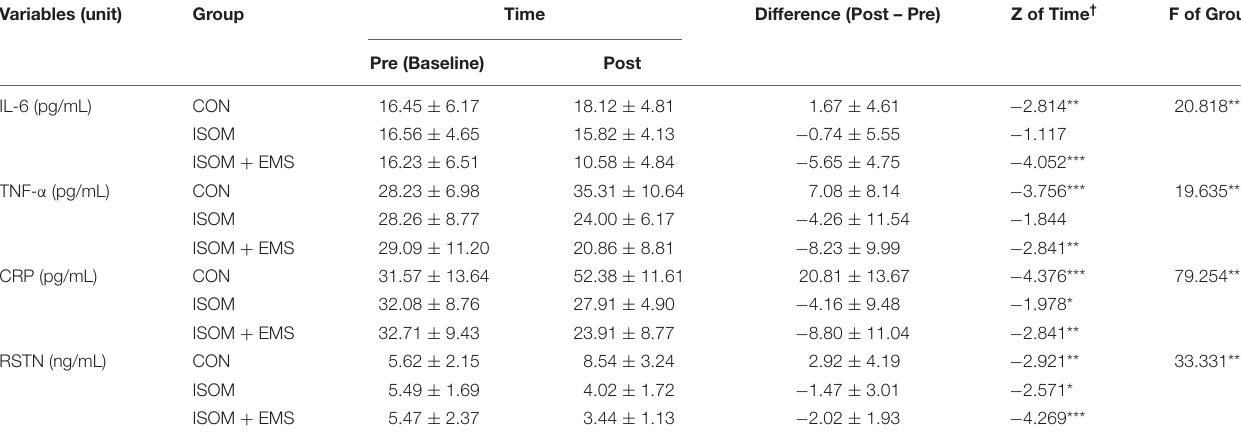
TABLE 6 | Differences and changes in